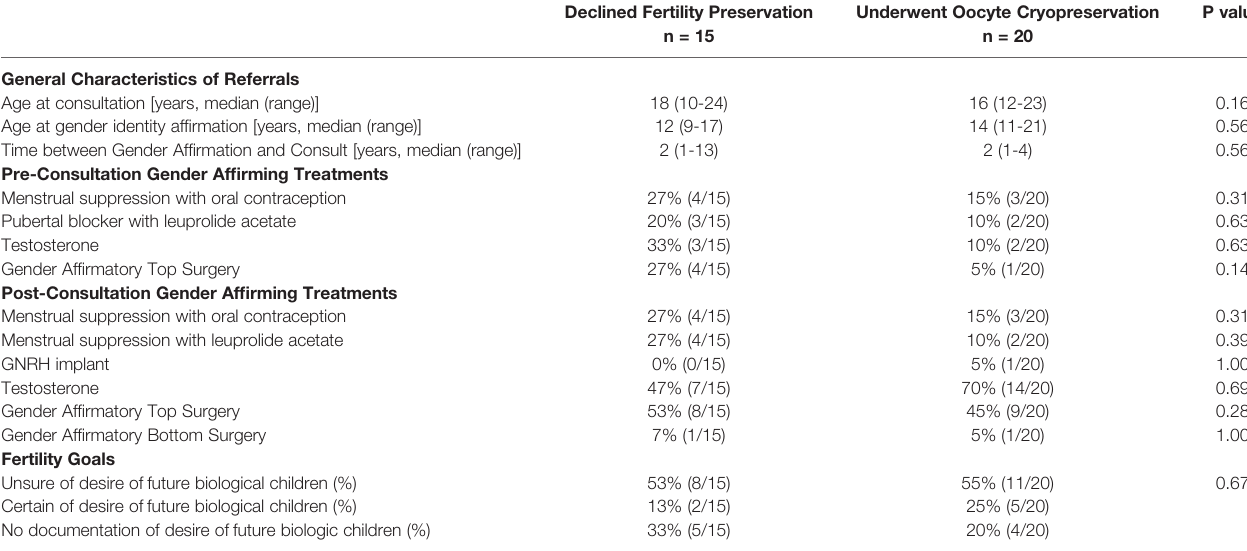
TABLE 2 | Characteristics of AYA transmen who underwent fertility preservation consultation with a Reproductive Endocrinology and Infertility